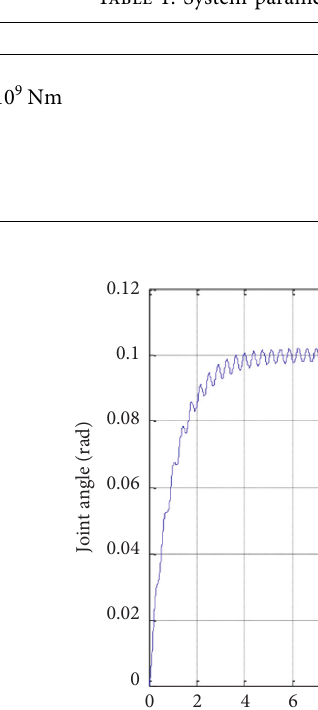
Figure 3: The flexible manipulator system with four PZT actuators. Table 1: System parameters of the flexible manipulator.